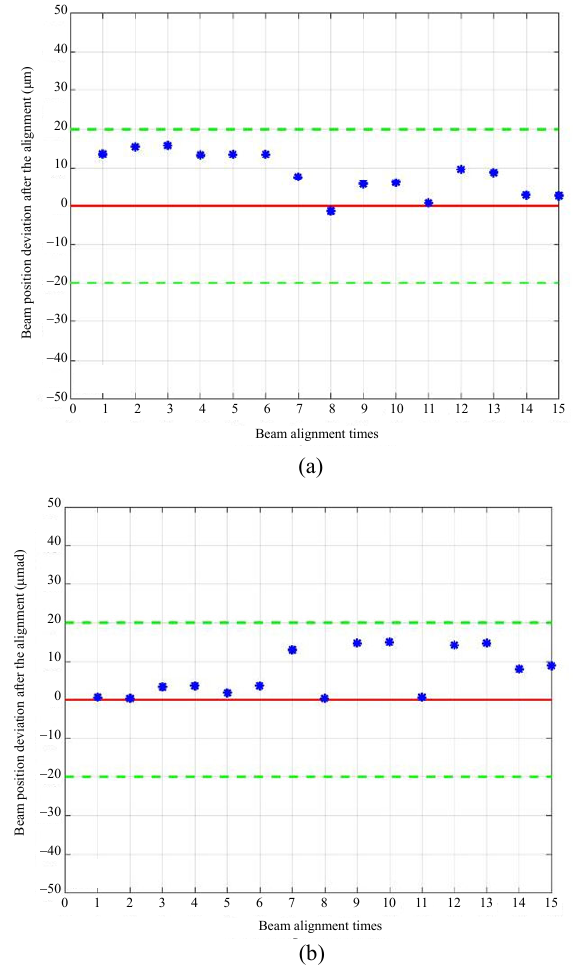
Fig. 6 Beam position and angle deviations after the alignment with the PLW iterative algorithm in 15 repeated experiment: (a) and (b) show the beam position and angle deviations,